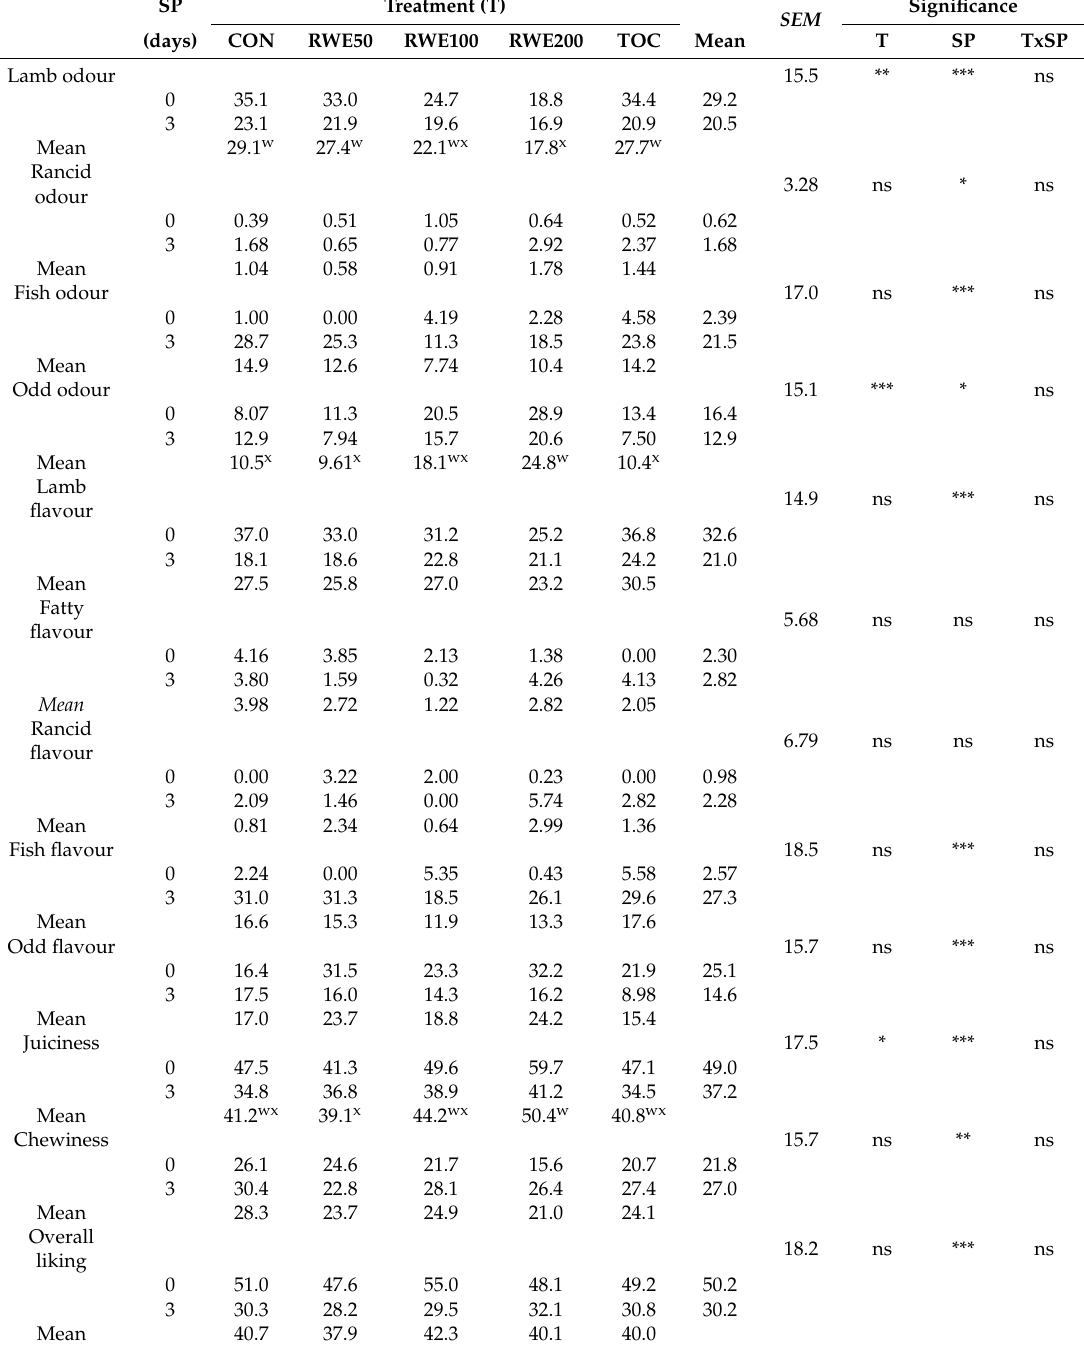
Table 3. Sensory evaluation of cooked n -3 enriched lamb meat patties over the 9-day storage period (SP) in high oxygen modified atmosphere packs (HiOx-MAP), containing different levels of